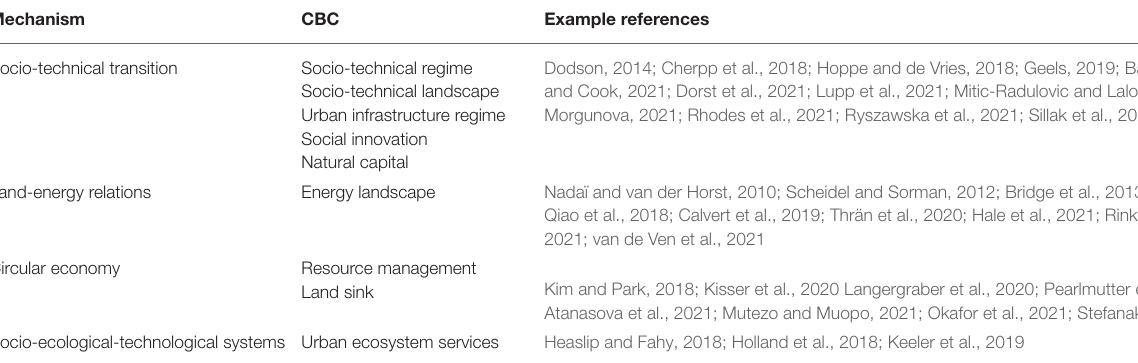
TABLE 1 | Overview of the mechanisms and associated CBC of the NbS and